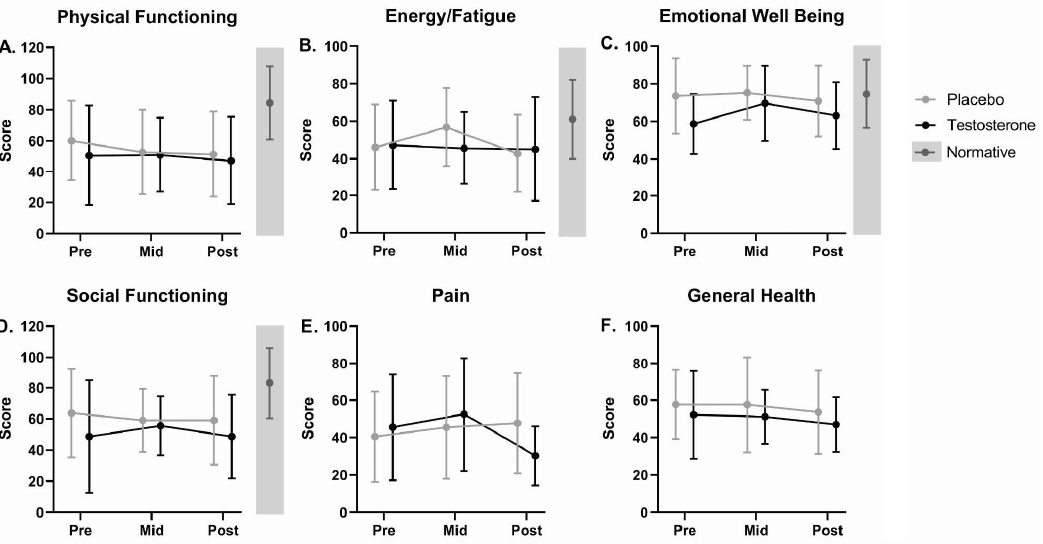
Figure 7. RAND 36-Item Health Survey 1.0 (SF-36) scale scores at pre, mid, and post for cancer patients receiving testosterone or placebo. Average (±SD) scores for ( A ) Physical Functioning, ( B ) Energy/Fatigue, ( C ) Emotional Well Being, ( D ) Social Functioning, ( E ) Pain, and ( F ) General Health scales. Average (±SD) normative scores [67], as available, are displayed in gray sidebars to the right of each graph. There were no significant differences between groups or in scores over time for either group. Lower scores on presented questionnaires are undesirable and indicate greater symptom severity.